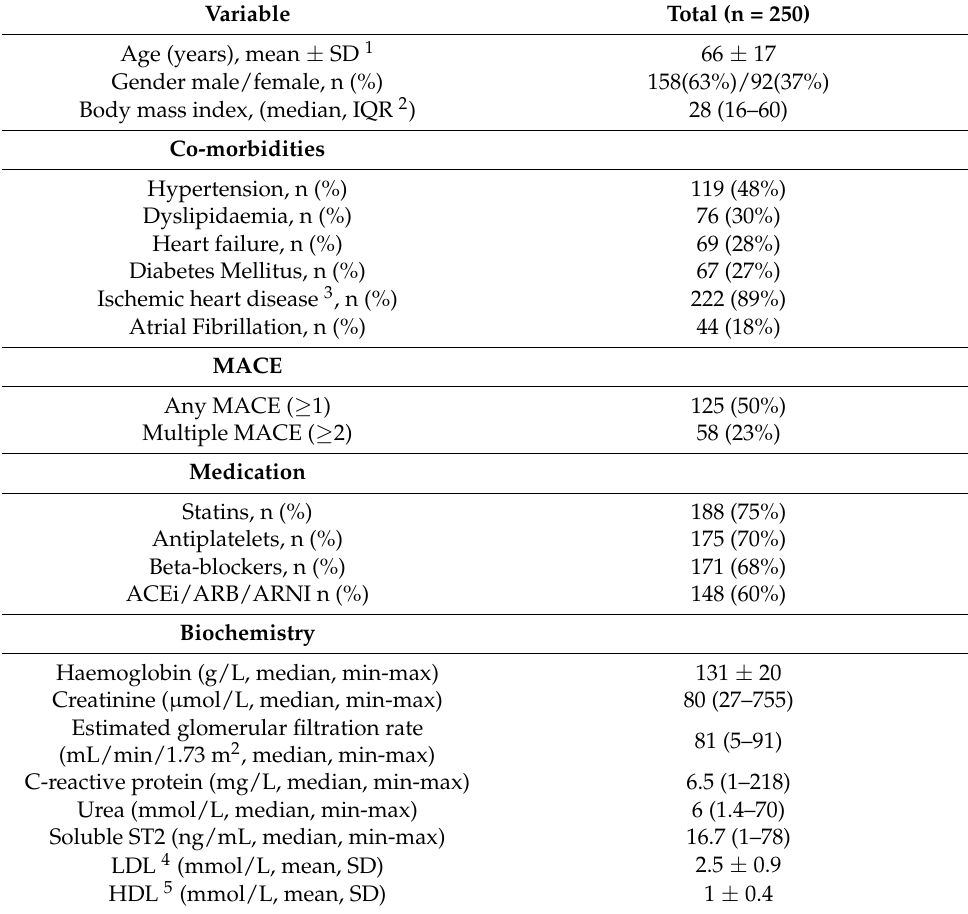
Table 1. Baseline patient characteristics.